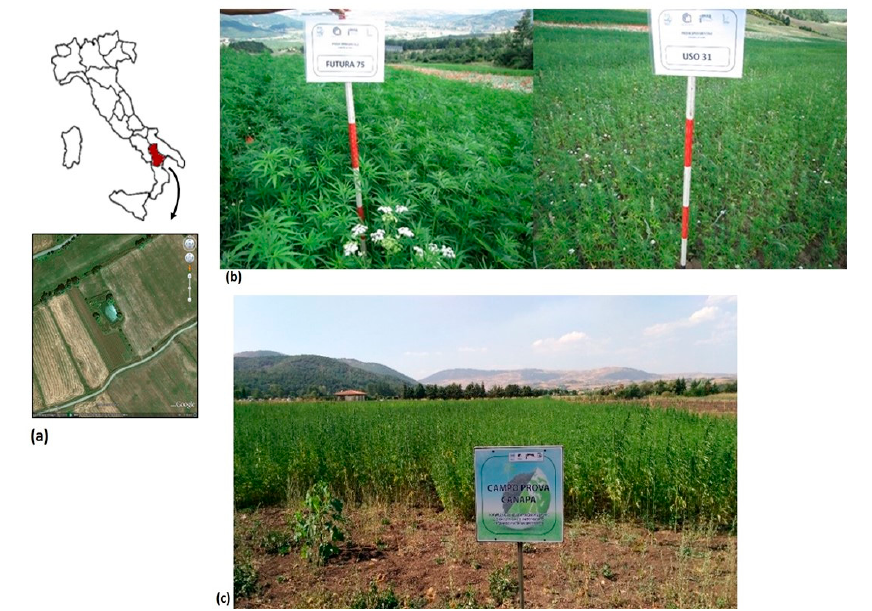
Figure 1. ( a ) Location of the study area in southern Italy (Google Earth 2015); ( b ) The Futura 75 and Uso 31 hemp crop varieties of 2016 used for this study; ( c ) The Futura 75 hemp crop variety applied for this study in